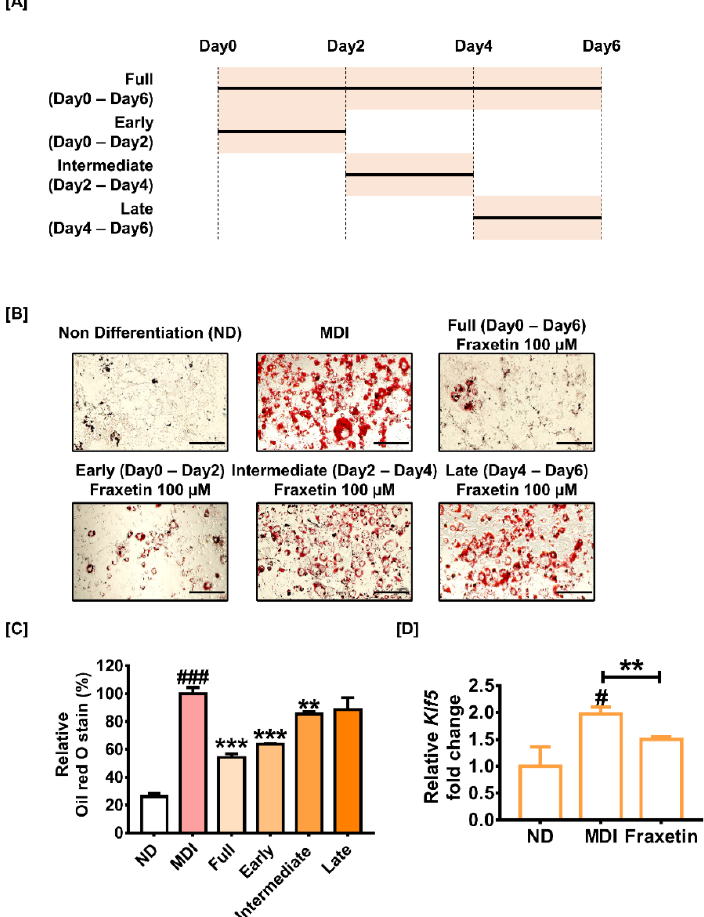
Figure 3. Effect of fraxetin on various stages of adipogenesis in 3T3-L1 cells. ( A ) Schematic diagram of the treatment period of fraxetin (100 µM) in confluent 3T3-L1 cells during adipogenesis. ( B , C ) The nondifferentiated cell and differentiated cells treated with fraxetin (100 µM) at different periods of adipogenesis were stained with oil red O solution on day 8. Relative lipid droplets eluted by isopropanol were quantified by measuring the absorbance at 490 nm. Scale bar: 50 µm. ( D ) Transcriptional expression of the Klf5 gene was analyzed by RT-qPCR. All data were obtained in triplicate. The asterisk symbol represents significant differences between the MDI-treated group and others (** p < 0.01, *** p < 0.001). The crosshatch symbol represents significant differences between the nondifferentiated group and others (# p < 0.05, ### p < 0.001), as verified using unpaired t -tests or one-way analysis of variance (ANOVA), followed by Dunnett’s post hoc